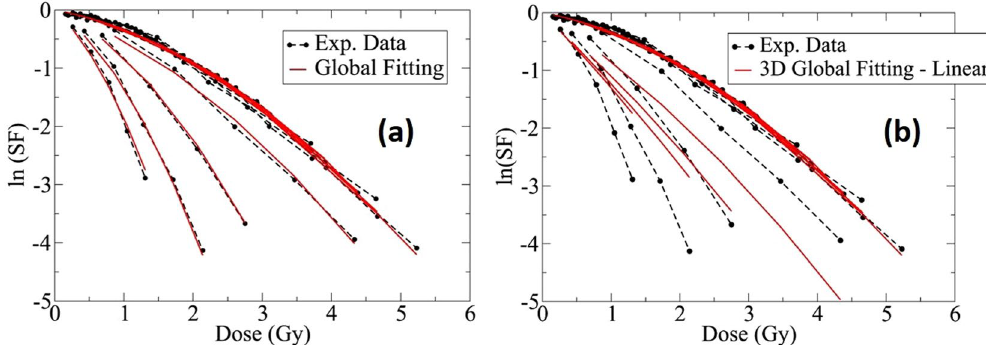
Figure 6. 2D representation of the survival fraction shown in Fig. 3 (H460 cells) using non-linear gMKM fitting polynomials (left panel) and linear MKM polynomials in Fig. 4 (right panel). The black dotted lines represent the experimental data and the red lines are the fitted surfaces projected to the SF-Dose